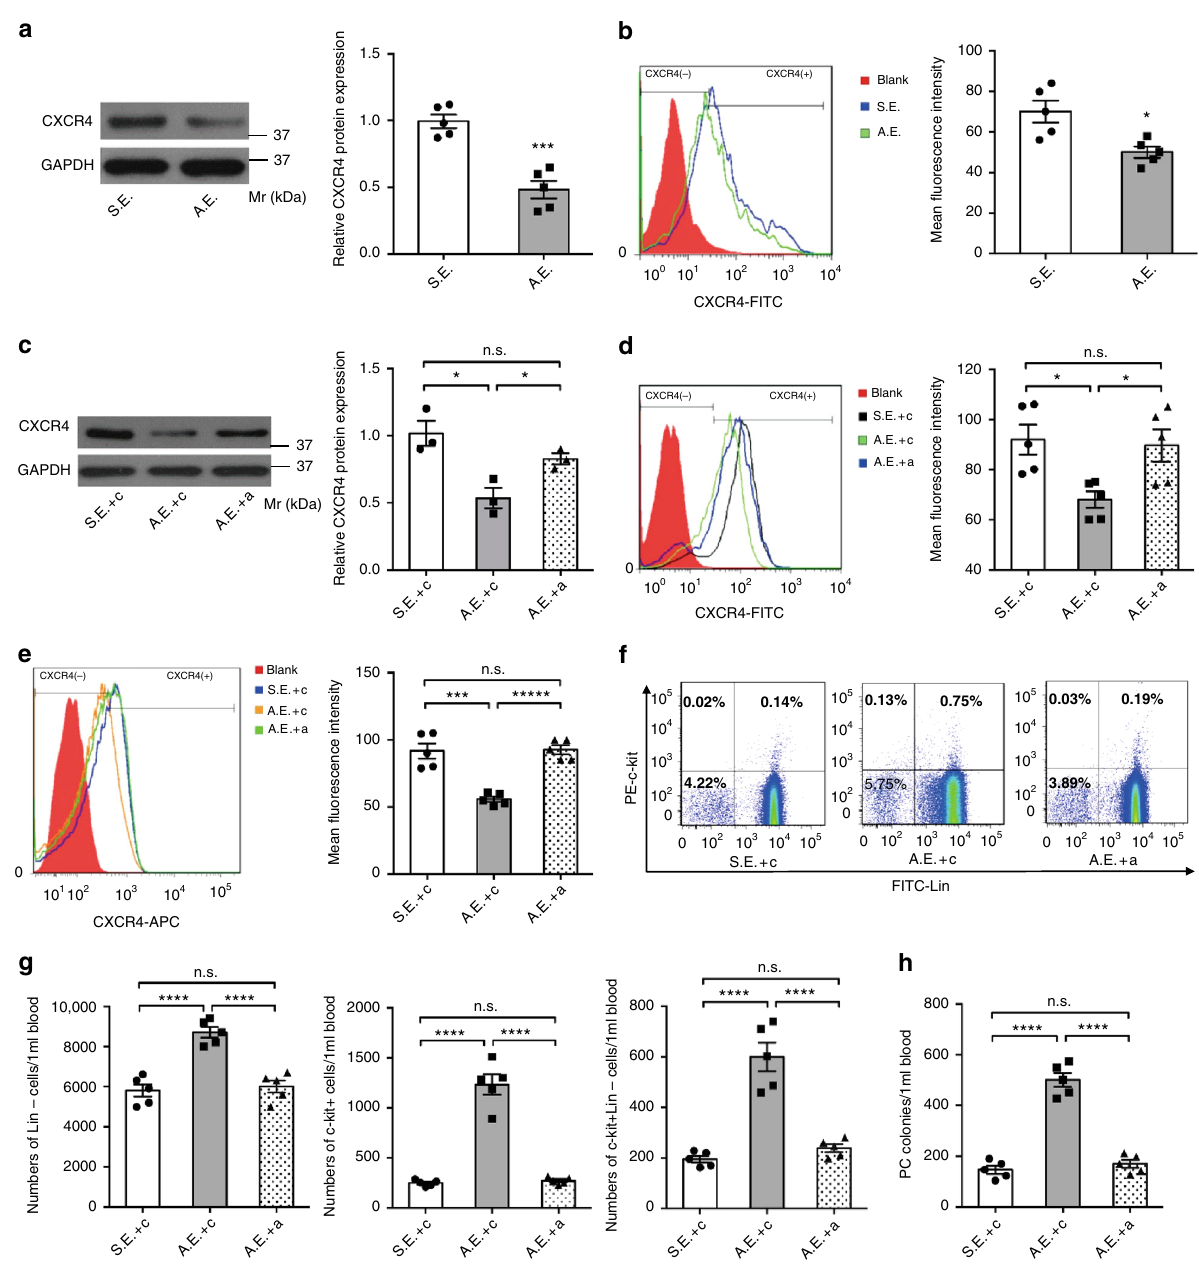
Fig. 4 Exosomal transfer of myo-miRs downregulates CXCR4 in BM-MNCs and induces BM PC mobilization. Exosomes were isolated from the plasma